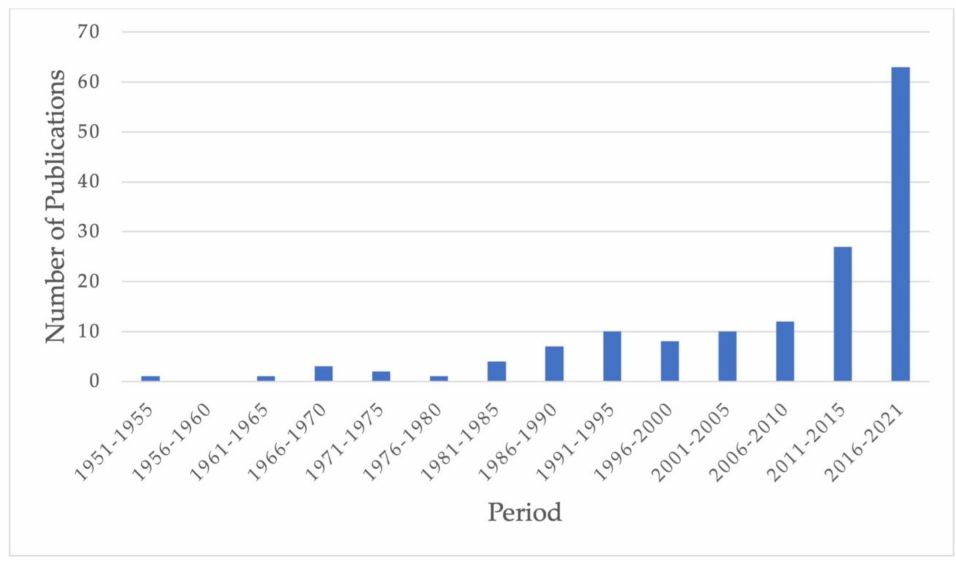
Figure 2. Dynamics of publications concerning 212 Pb and its production for nuclear medicine (including